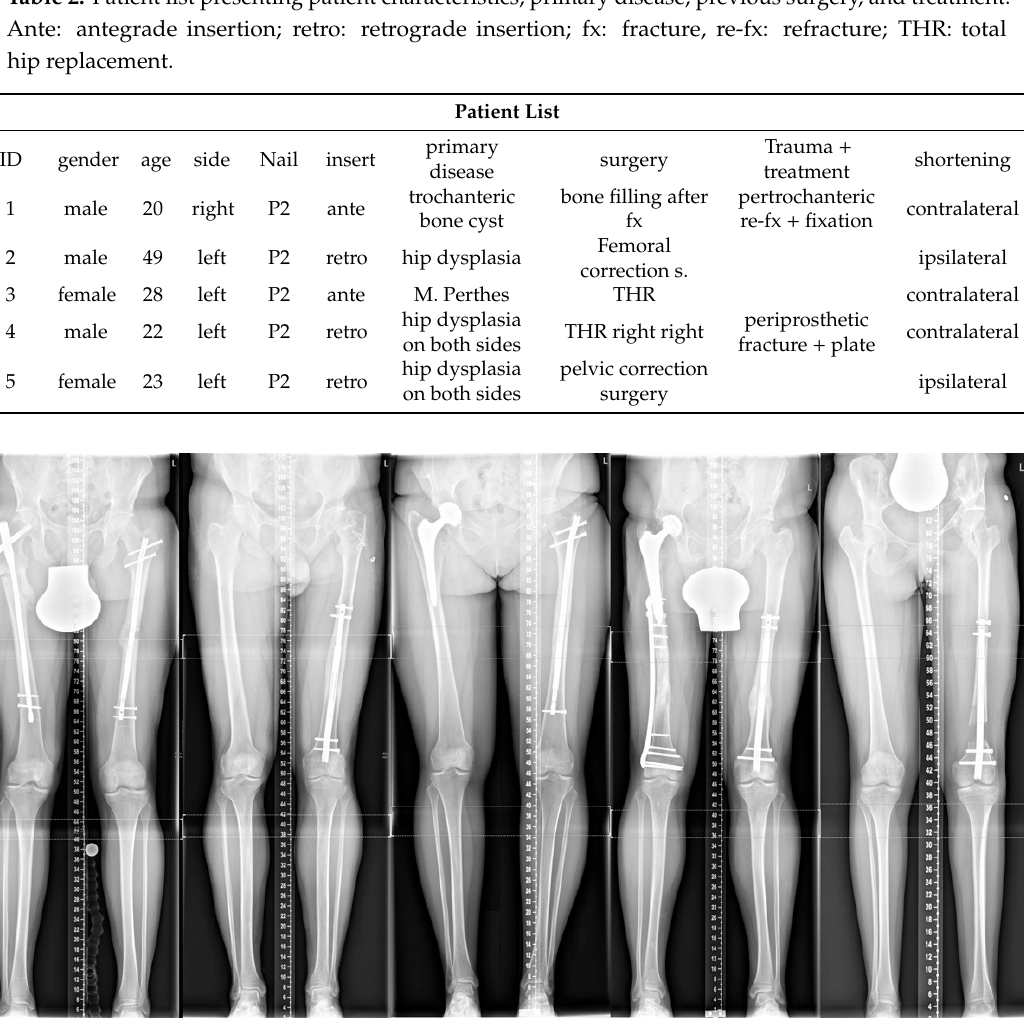
Figure 1. Long-standing radiographs are presenting all five patients (1 to 5).